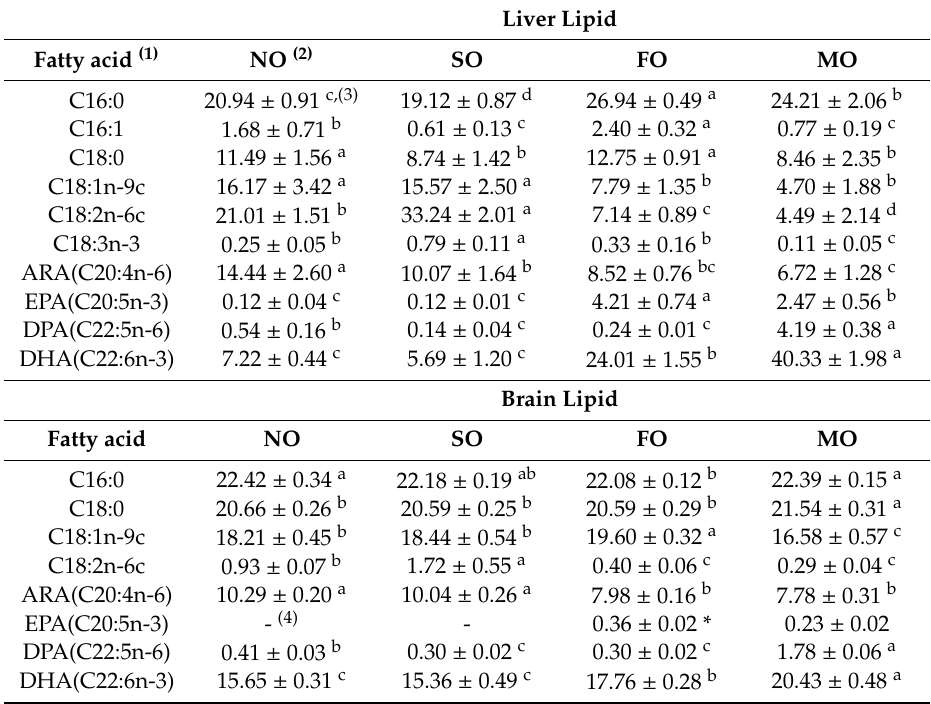
Table 5. The fatty acid composition distributed in liver and brain lipid of